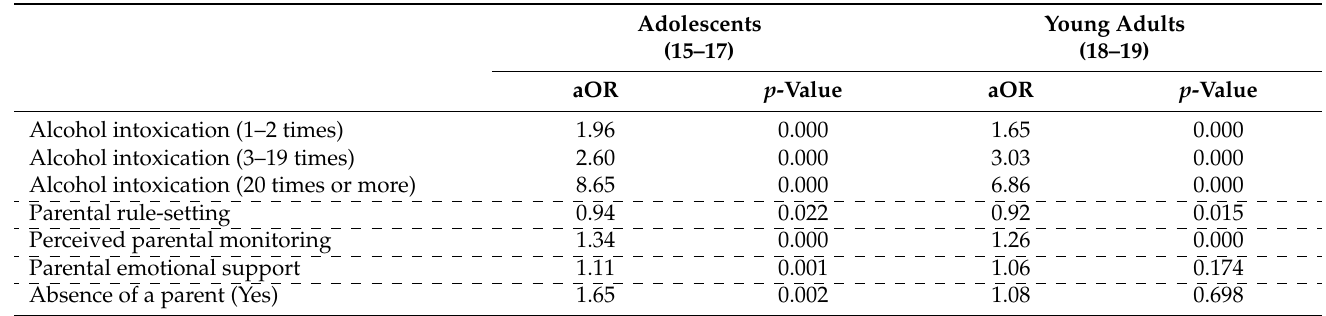
Table 4. Binary logistic regression models between alcohol intoxication in the past 12 months, parenting indicators, and violent behaviour among adolescents and young adults.